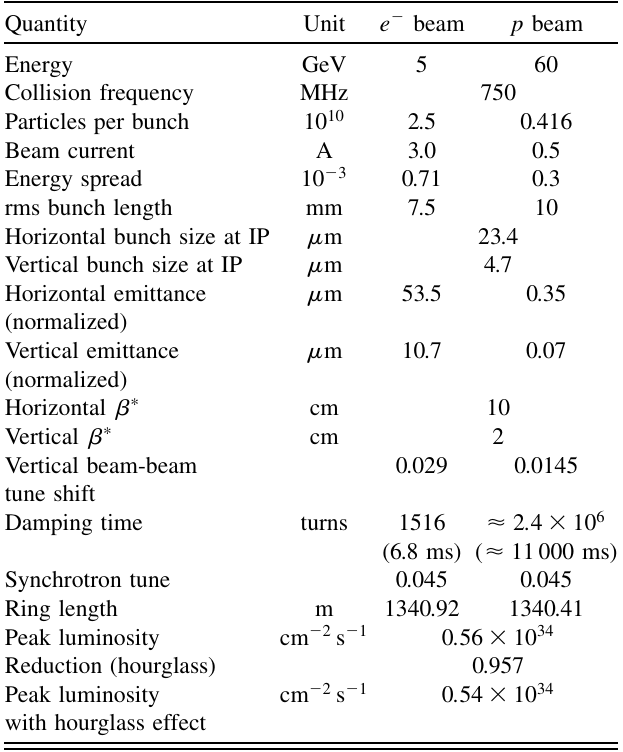
TABLE II. Model parameters for the MEIC at Jefferson Lab [33,34].